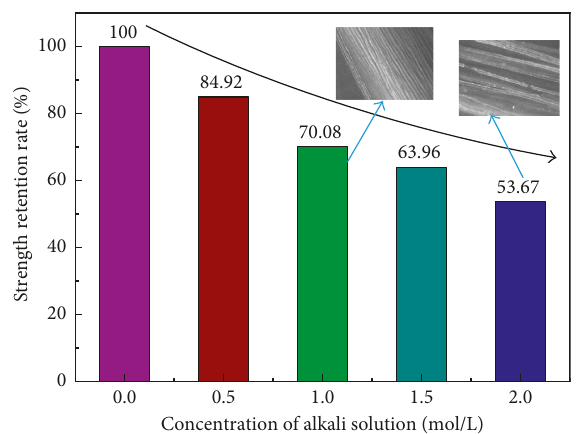
Figure 3: The effect of alkali concentration on the twisted BF